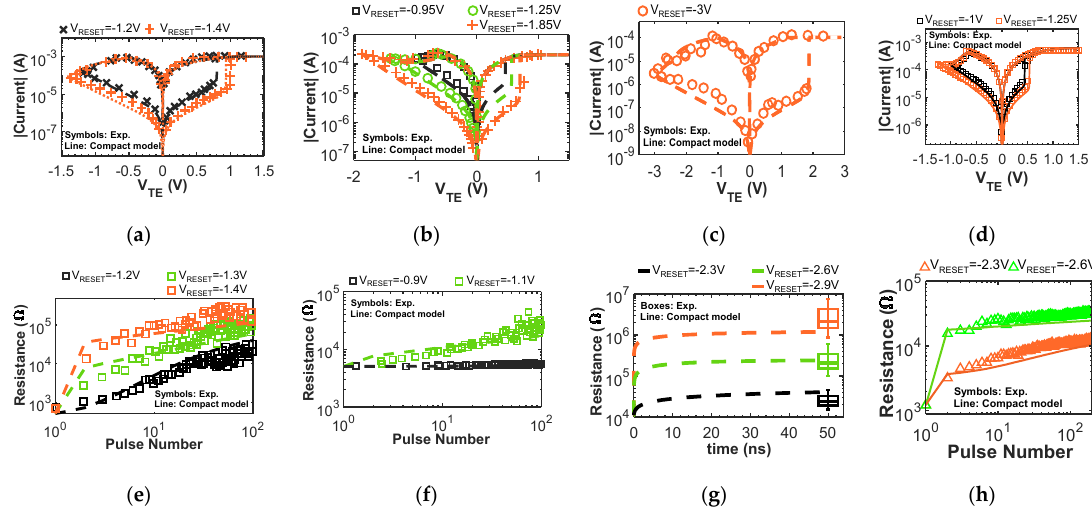
Figure 1. ( a , e ) Simulated (lines) and experimental (symbols) results of a multi-layer Pt/TiO x /HfO x /TiO x /HfO x /TiN RRAM formed at I C = 1 mA, technology 1 in this work. ( a ) DC I-V curves at different reset voltages. ( e ) Pulsed reset curves using a train of 10 ns pulses with different voltages. Data from [25]. ( b , f ) Simulated (lines) and experimental (symbols) results of a mono-layer TiN/HfO 2 /Ti/TiN RRAM formed at I C = 200 µ A, technology 2 in this work. ( b ) DC I-V curves at different reset voltages. ( f ) Pulsed reset curves using a train of 1 µ s pulses with different voltages. Data from [27]. ( c , g ) Simulated (lines) and experimental (symbols) results of a bi-layer TiN/HfO x /AlO x /Pt RRAM formed at I C = 100 µ A, technology 3 in this work. ( c ) DC I-V curve. ( g ) Pulsed reset curves using a single 50 ns pulse with different voltages. Data from [29]. ( d , h ) Simulated (lines) and experimental (symbols) results of a TiN/Ti/HfO x /TiN from SEMATECH [22] RRAM formed at I C = 500 µ A, technology 4 in this work. ( d ) DC I-V curve. ( h ) Pulsed reset curves using a train of 10 µ s pulses with different voltages. Data collected